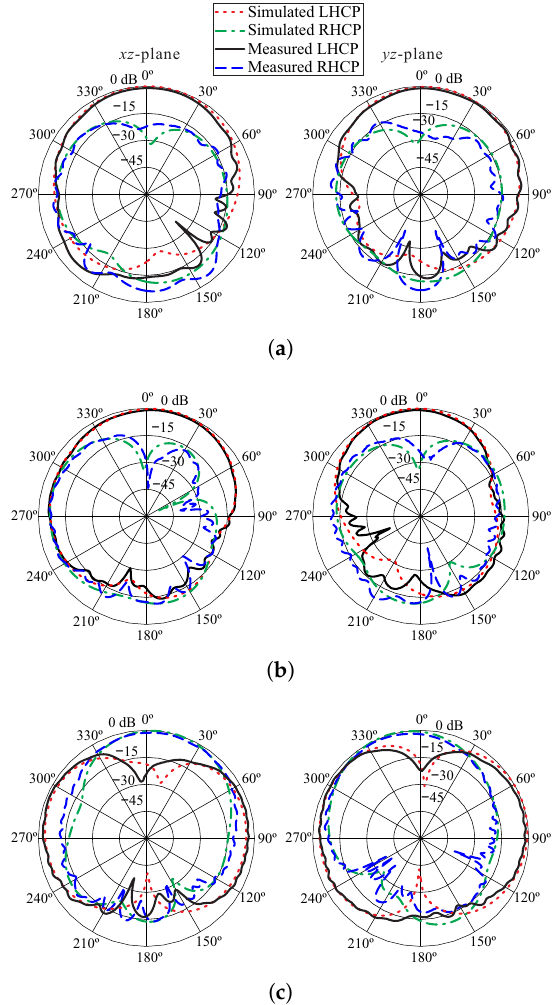
Figure 11. Normalized simulated and measured radiation patterns of the proposed antenna: ( a ) 1.9 GHz; ( b ) 2.73 GHz; ( c ) 3.7 GHz. Left-handed circular polarization (LHCP), right-handed circular polarization (RHCP).